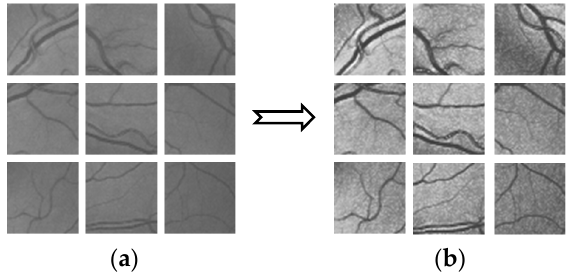
Figure 2. Pre-processing ( a ) original image ( b ) pre-processing results